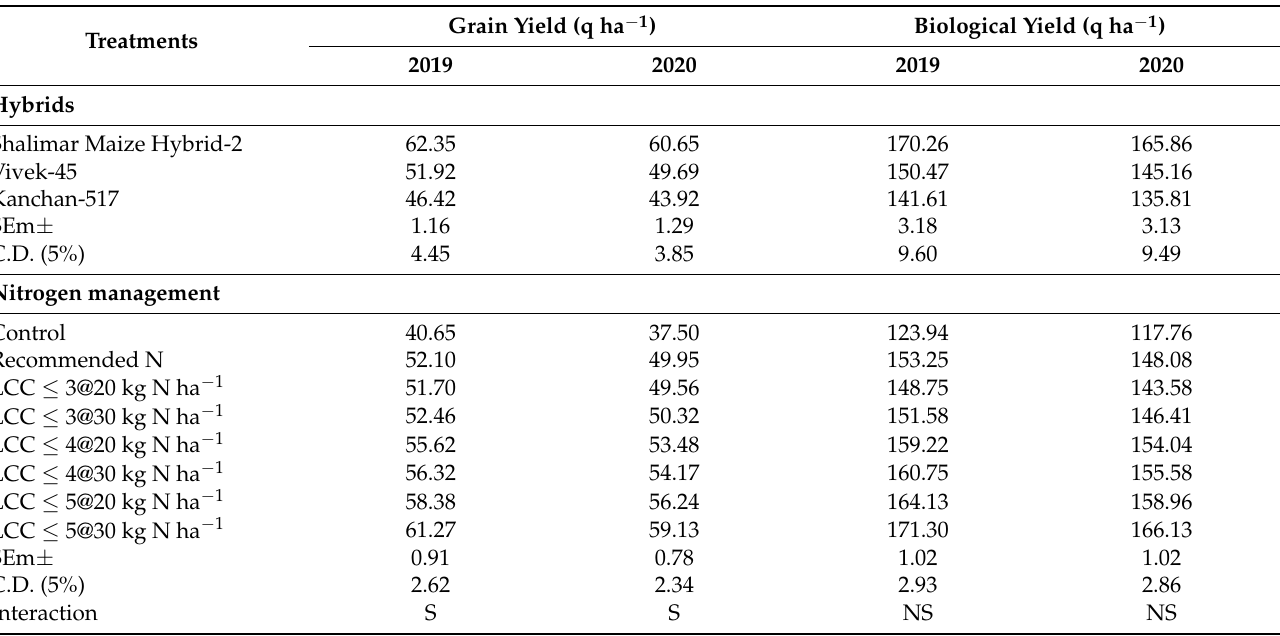
Table 9. Effect of real-time nitrogen management through LCC on yield of different hybrid maize